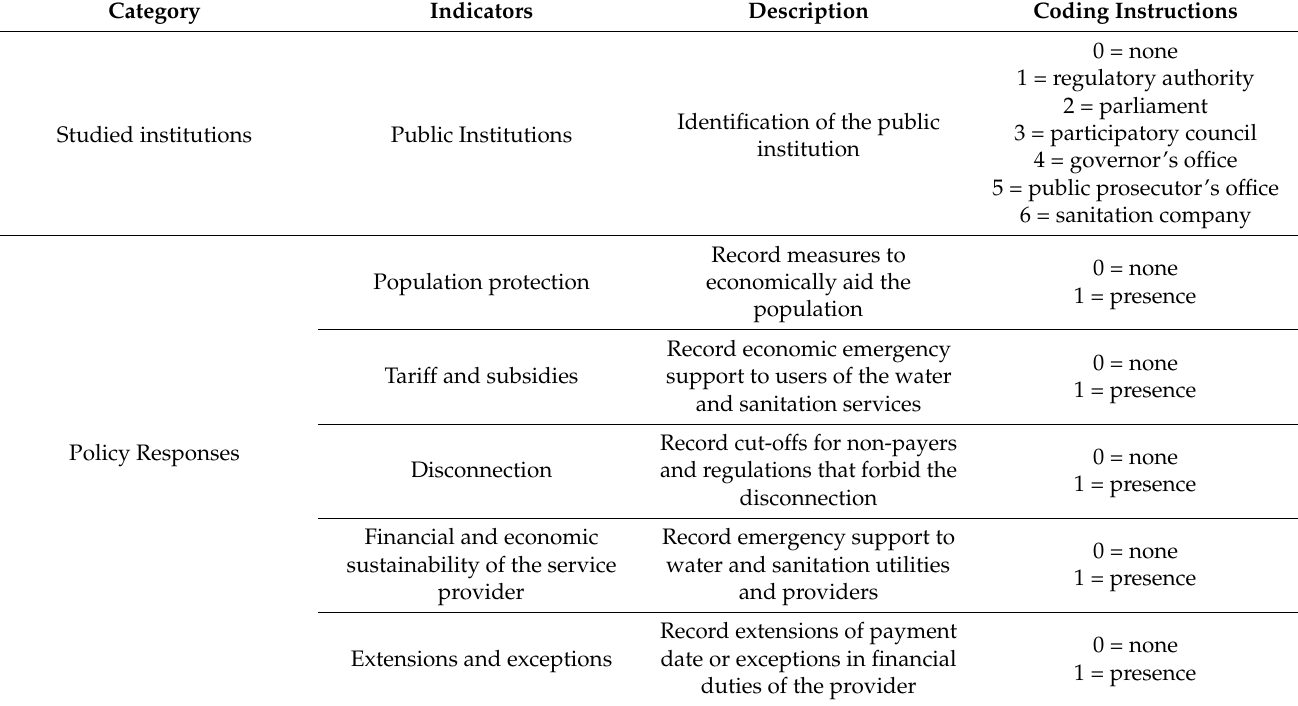
Table 2. Codebook utilized in the content analysis of the policies and regulations focused on water, sanitation, and hygiene. Category Indicators Description Coding